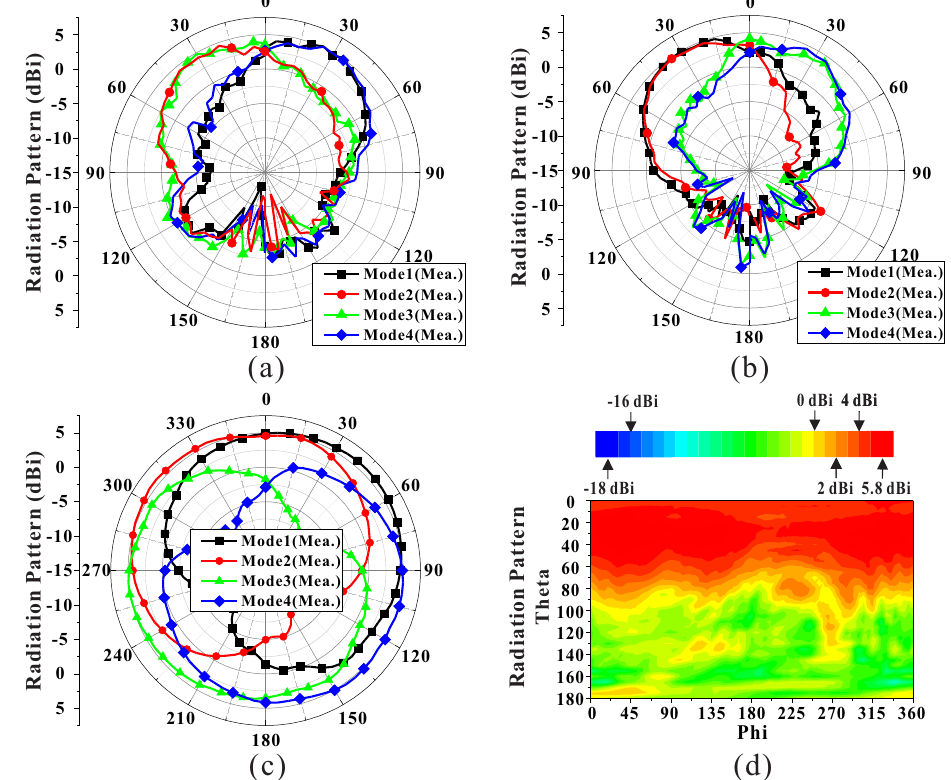
Figure 8. Measured radiation patterns and combined results of four input modes at 5.09 GHz: ( a ) zx -plane, ( b ) zy -plane, ( c ) azimuth plane at θ = 30 ◦ , and ( d ) combined radiation beam pattern of four input